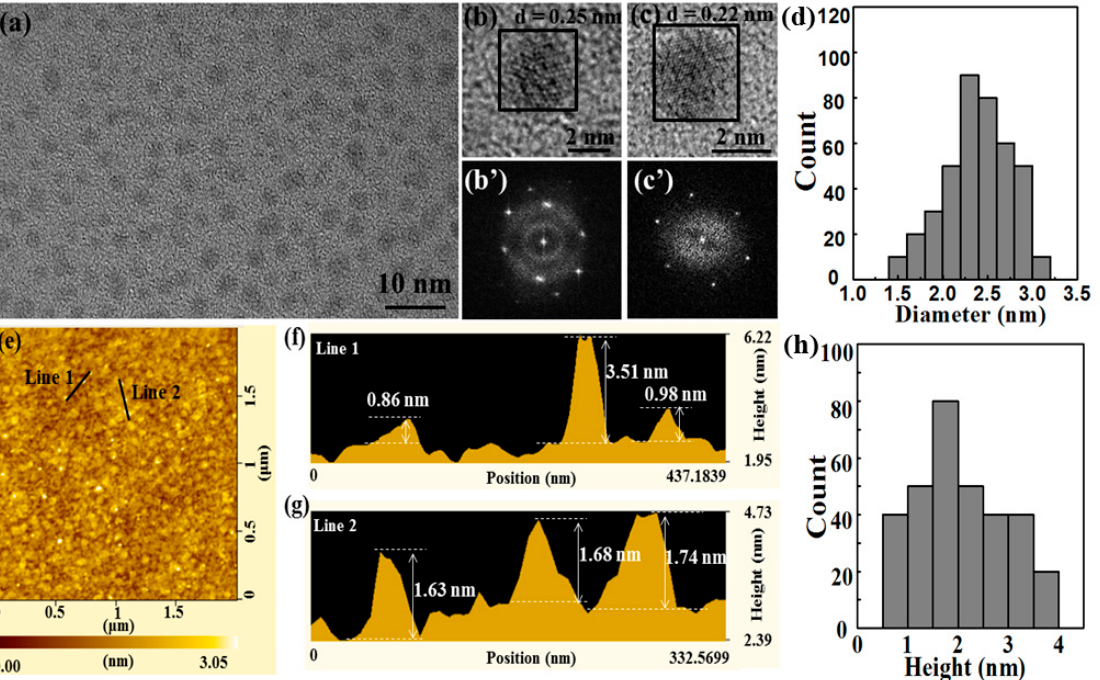
Figure 3. Structural characterization of the BPQDs in ethanol: ( a ) TEM of the BPQDs, ( b , c ) HRTEM and ( b’ , c’ ) the corresponding FFT of the BPQDs, ( d ) histogram of the lateral size measured, ( e ) AFM image of the BPQDs, ( f , g ) statistical analysis of the heights of the BPQDs measured by AFM, and ( h ) histogram of the height measured.